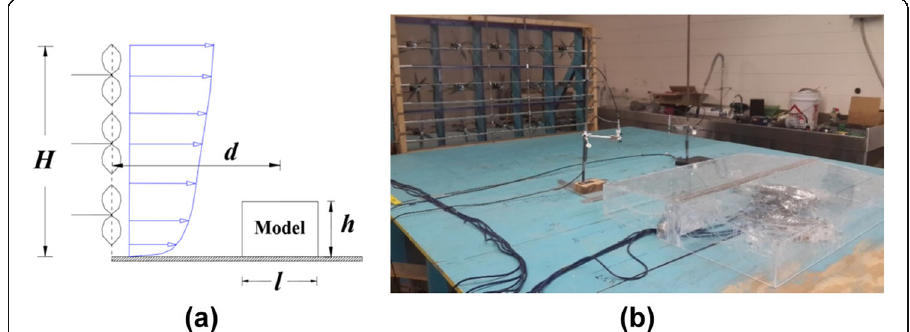
Fig. 4 Open-jet wind testing: ( a ) main concept, and ( b ) small-scale open-jet simulator at Louisiana State University